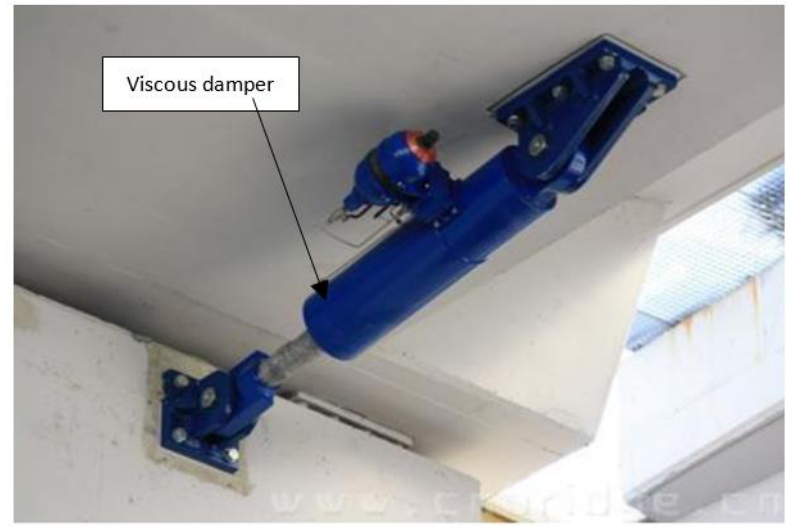
Figure 3. Viscous damper reproduced from [40].